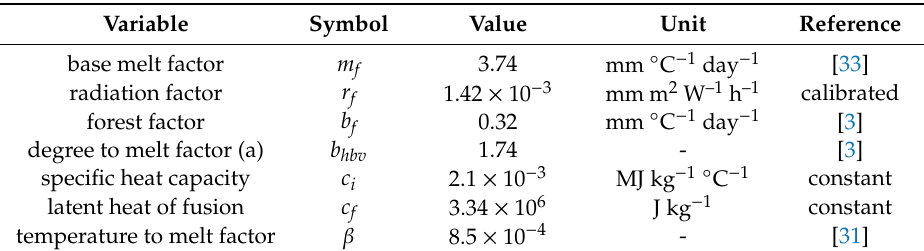
Table 2. Set of parameters used in this